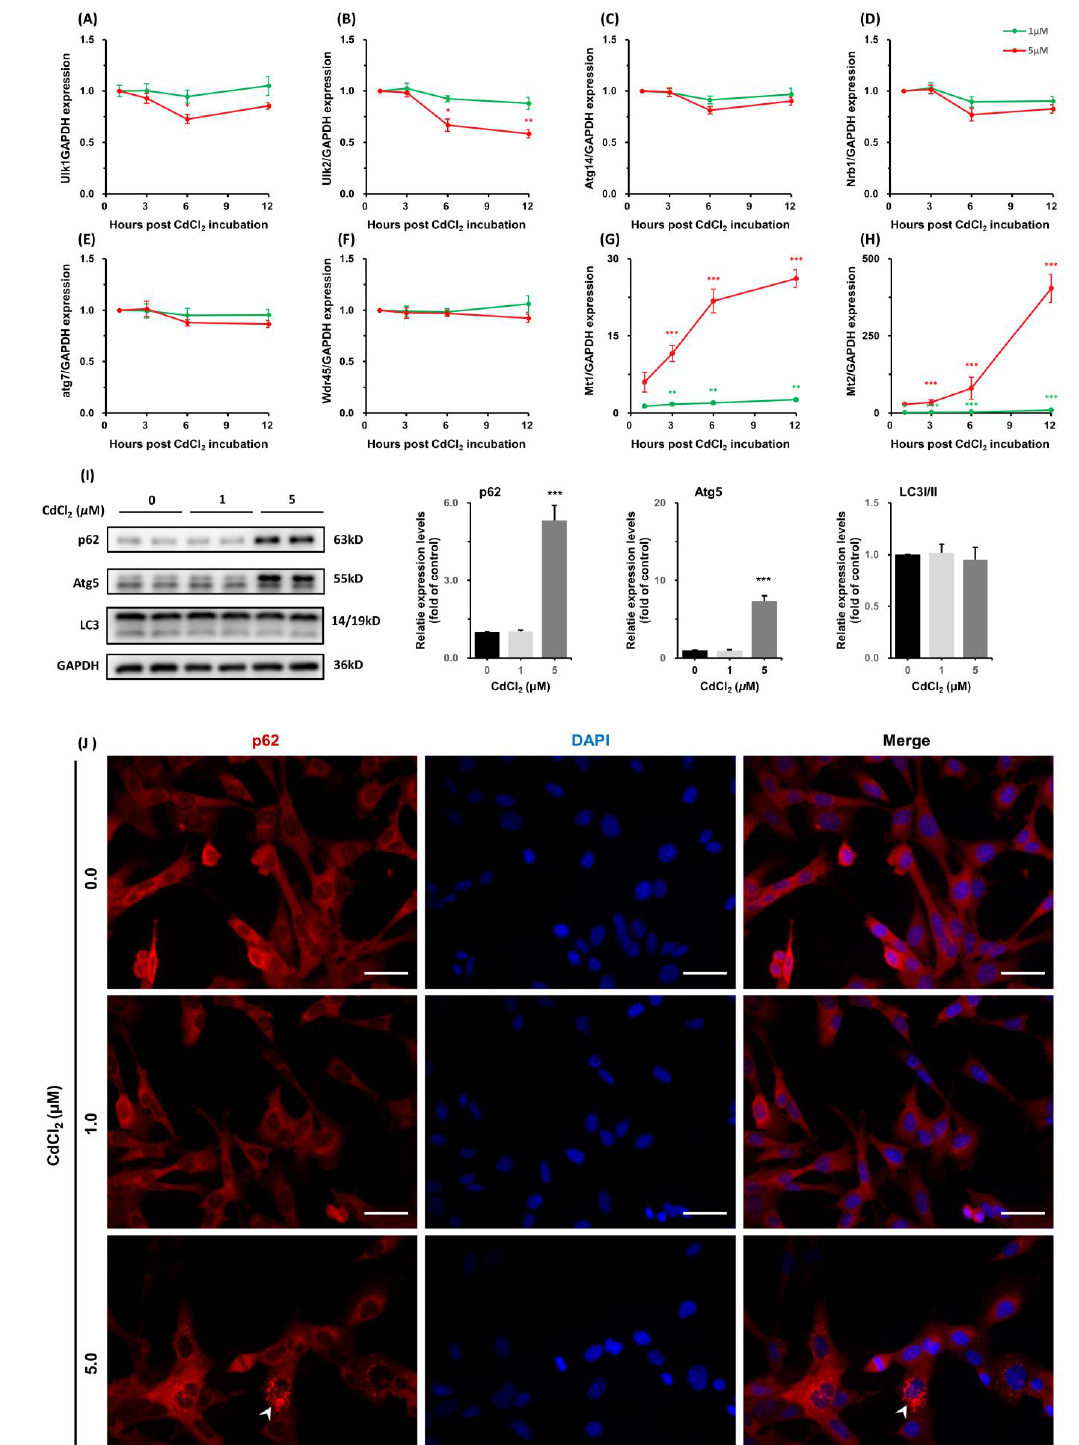
Figure 5. CdCl 2 suppressed the autophagy activities and increased MT transcription in TM4. The mRNA levels of genes monitoring autophagy were measured using qPCR after treatment with CdCl 2 (1, 5 µ M) for 1, 3, 6, and 12 h ( A – F ). The protein levels of p62, Atg5, and LC3 after treatment with CdCl 2 (1, 5 µ M) for 12 h were measured by immunoblotting ( I ). Changes in expression of cellular p62 (red) were examined by immunofluorescence microscopy ( J ). The mRNA levels of MT1 and MT2 were also measured at the indicated time ( G , H ). Scale bar 50 µ m for immunofluorescence images. *** p < 0.001 compared to the control